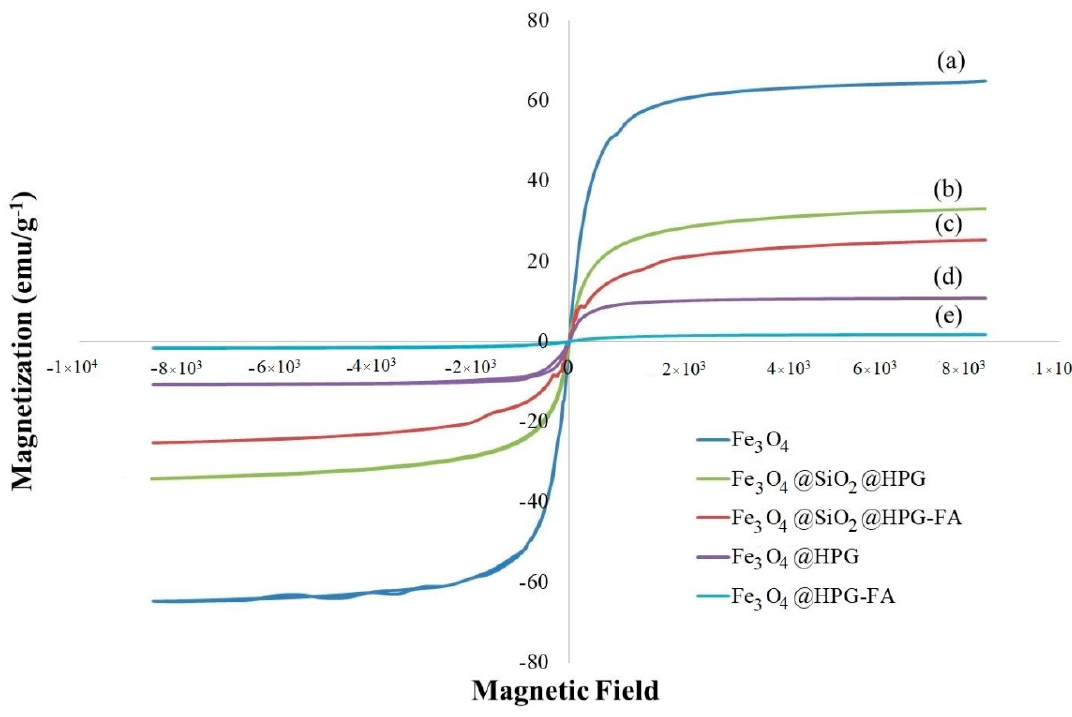
Figure6. Magneticbehaviorof( a )Fe 3 O 4 nanoparticles( b )Fe 3 O 4 @SiO 2 @HPG( c )Fe 3 O 4 @SiO 2 @HPG-FA Figure 6. Magnetic behavior of ( a ) Fe 3 O 4 nanoparticles ( b ) Fe 3 O 4 @SiO 2 @HPG ( c ) ( d ) Fe 3 O 4 @HPG ( e ) Fe 3 O 4 Fe 3 O 4 @SiO 2 @HPG-FA ( d ) Fe 3 O 4 @HPG ( e ) Fe 3 O 4 @HPG-FA .